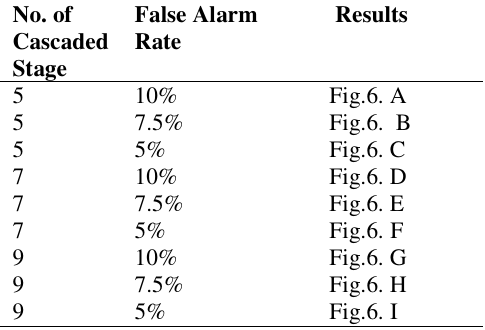
Number of Cascaded Stages & False Alarm Rate with their